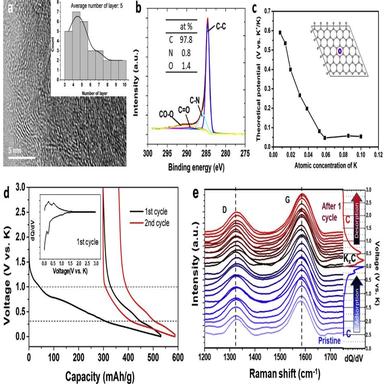
Potassium ion storage in partially ordered carbon. (a) TEM image of CNF-1250; (b) Deconvoluted C 1s spectra for CNF-1250; (c) Comparison between theocratical reaction potentials of potassium ion on graphene sheet and the 2nd discharge curve; (d) Voltage profiles of CNF-1250 at the current density of 25 mA/g, inset is the dQ/dV plot; (e) Selective in-situ Raman spectra of CNF-1250 with corresponding dQ/dV plot. (A colour version of this figure can be viewed online.)